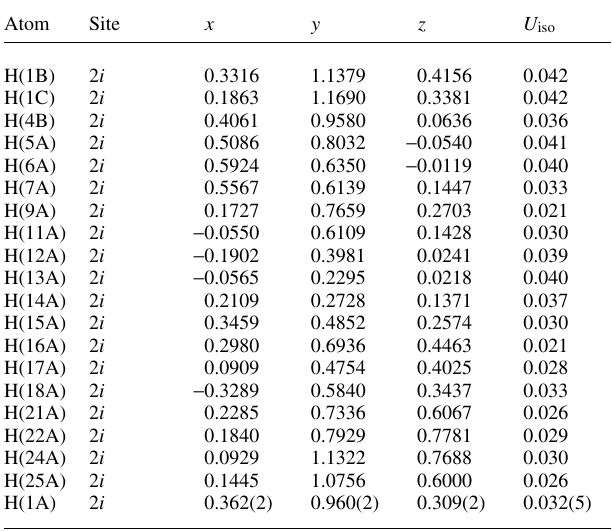
Table 2. Atomic coordinates and displacement parameters (in Å 2 )